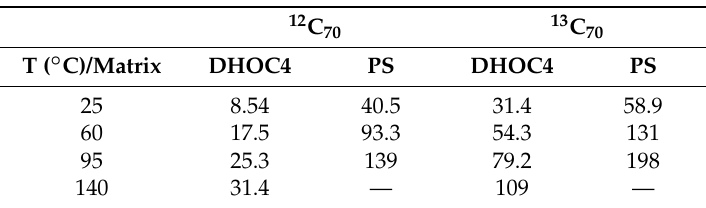
Table 2. I DF /I PF values of 12 C 70 and 13 C 70 in DHOC4 and